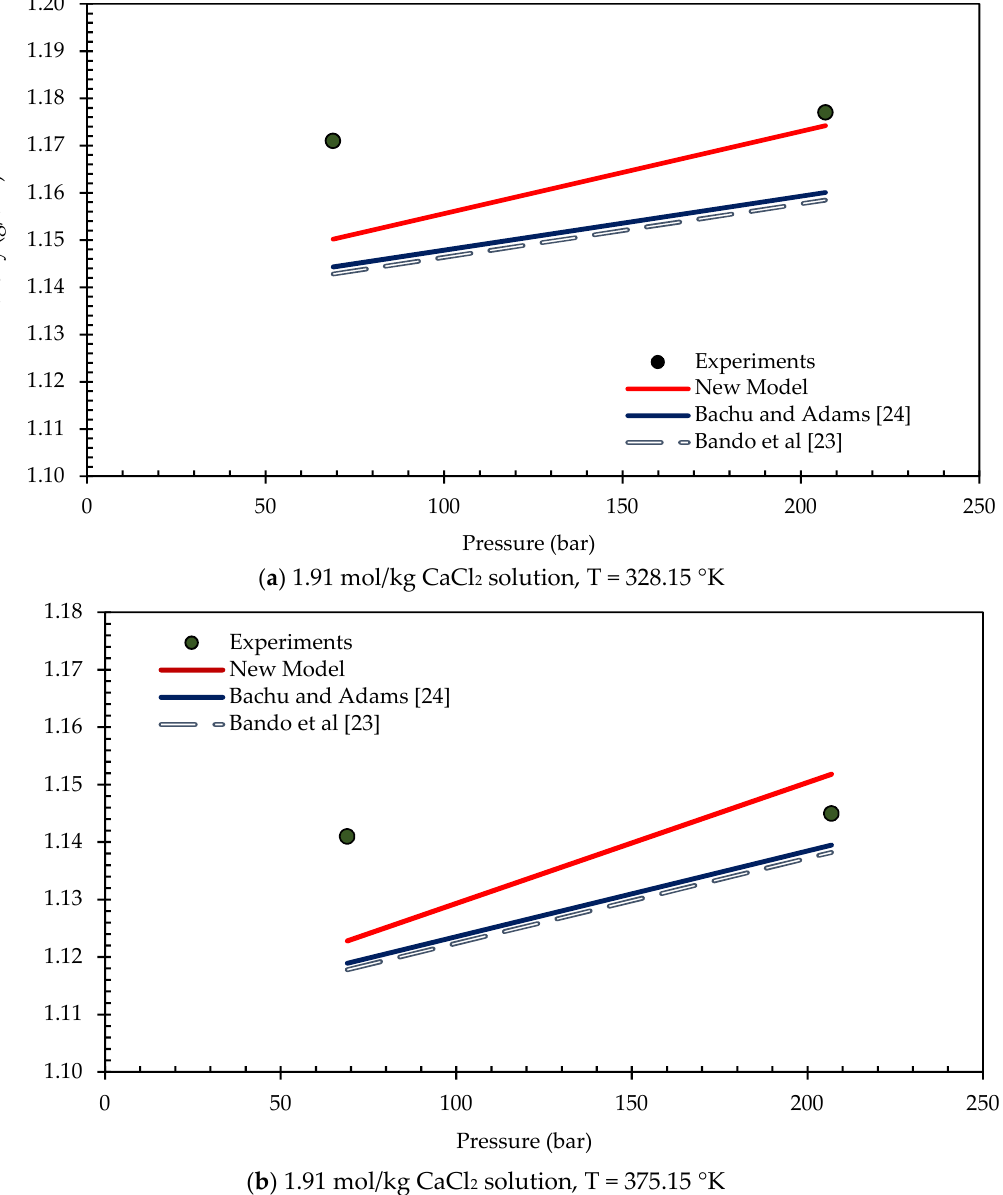
Figure 9. A comparison of experimentally measured and different model estimations for density of a 1.91 mol/kg-CaCl 2 solution saturated with CO 2 at ( a ) 328.15 °K and ( b ) 375.15 °K.